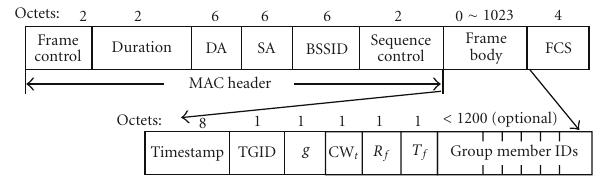
Figure 3: Frame format of token distribution